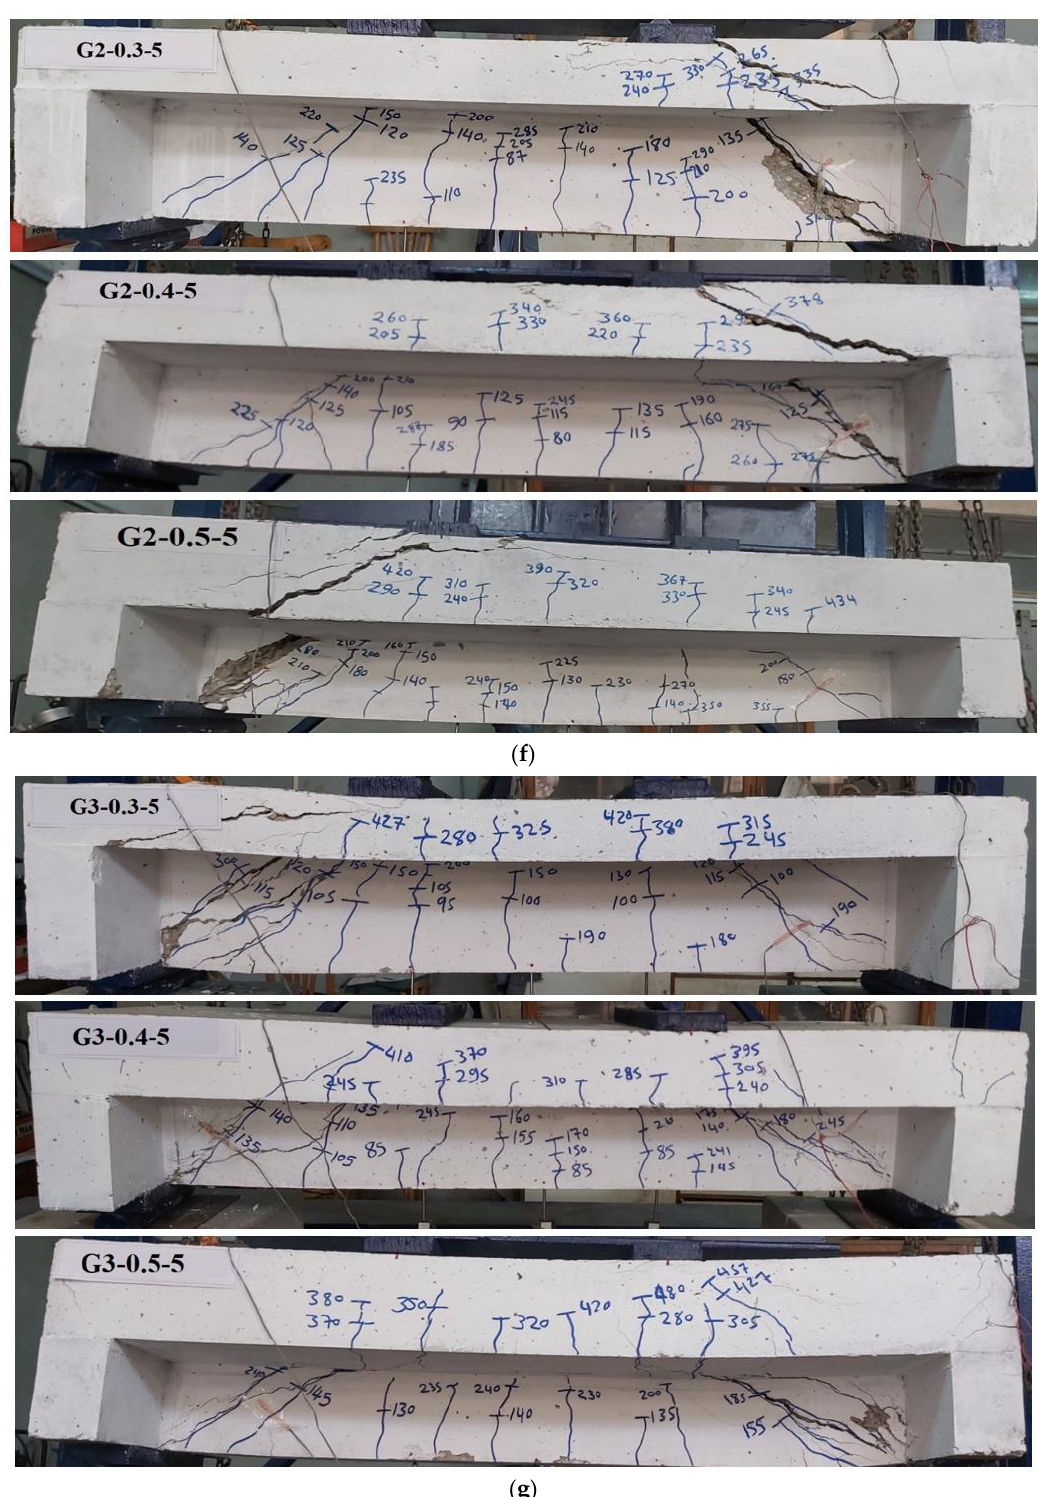
Figure 6. Experimental crack pattern for control beam and other flanged specimens. ( a ) Control beam; ( b ) specimens without reinforcement in flange ρ b = 3; ( c ) specimens with longitudinal reinforcement in flange ρ b = 3; ( d ) specimens with longitudinal steel and stirrups in flange ρ b = 3; ( e ) specimens without reinforcement in flange ρ b = 5; ( f ) specimens with longitudinal reinforcement in flange ρ b = 5; ( g ) specimens with longitudinal steel and stirrups in flange ρ b = 5.